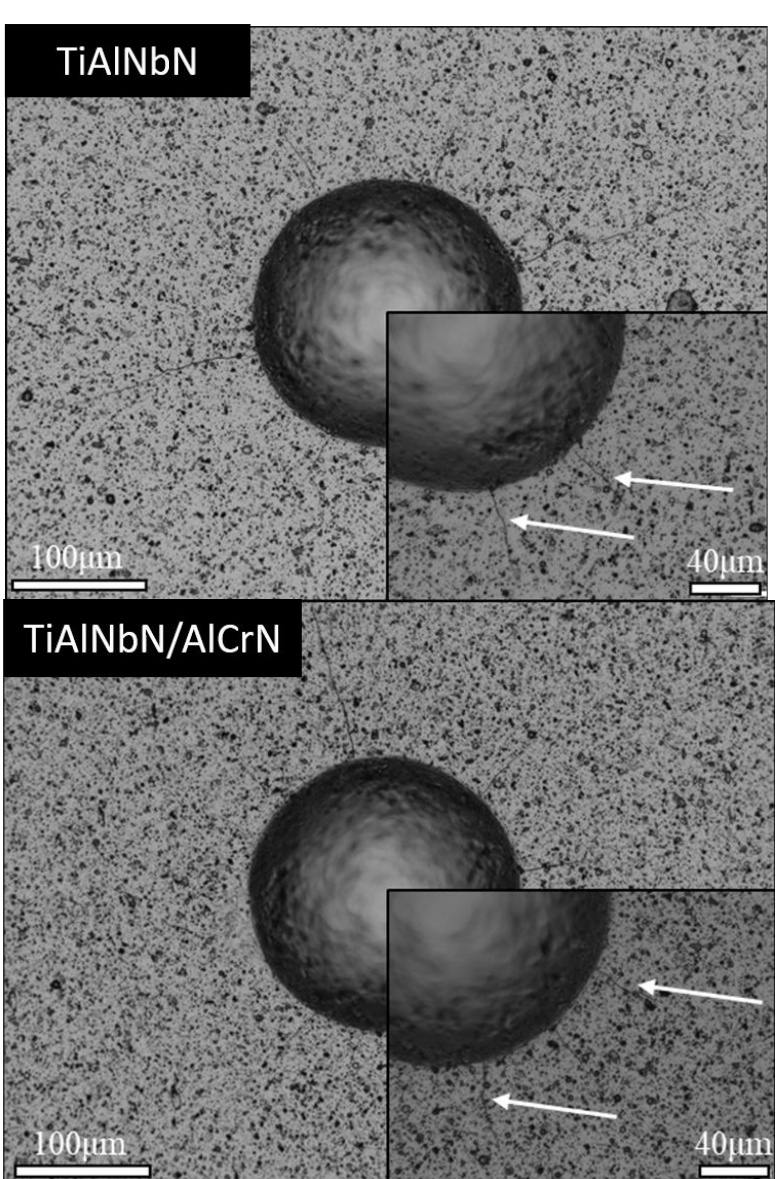
Figure 6. Optical micrographs of Rockwell indentations of the deposited TiAlNbN and multilayered TiAlNbN/AlCrN coatings on cemented carbide (WC- 8 wt.% Co) samples measured using Rockwell indentation. The white arrows indicate the radial cracks after indentation.